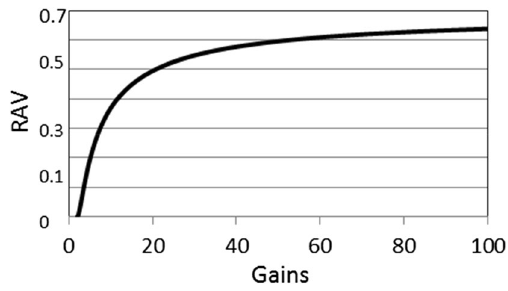
Fig. 2 Net cash value as a function of increasing fractional involve- ment for the case described in Fig. 1. One has an optimum working interest as shown in 27.7% and a peak NCV of 1.079